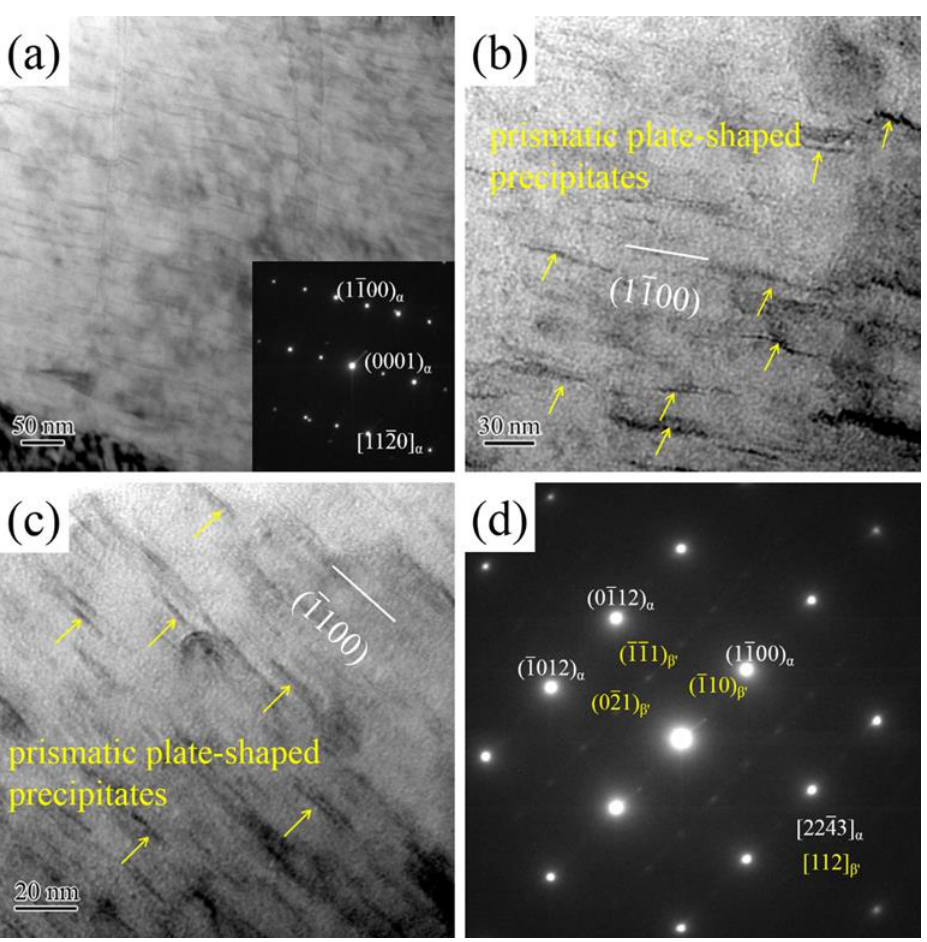
Figure 4. TEM bright-field images and corresponding SAED patterns of aged Mg-2.0Nd-2.0Sm-0.4Zn-0.4Zr alloy with solution treatment for 8 h: ( a , b ) the incident electron beam direction is parallel to the [112 ̅ 0] α ; ( c , d ) the incident electron beam direction is parallel to the [224 ̅ 3] α .